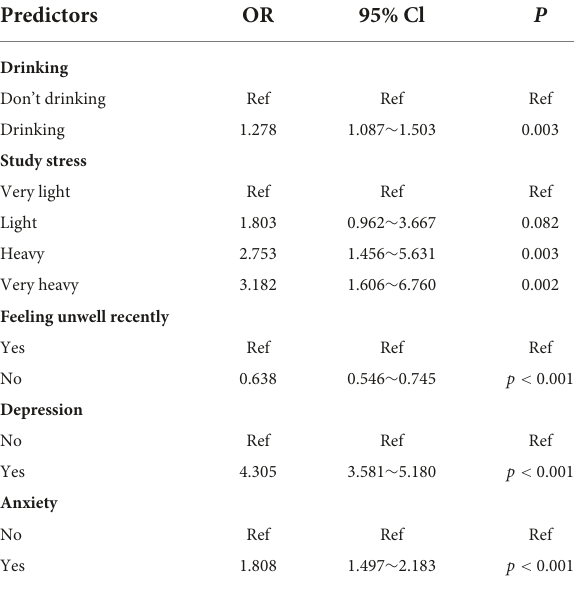
TABLE 4 The final model for predicting poor sleep quality among medical students.